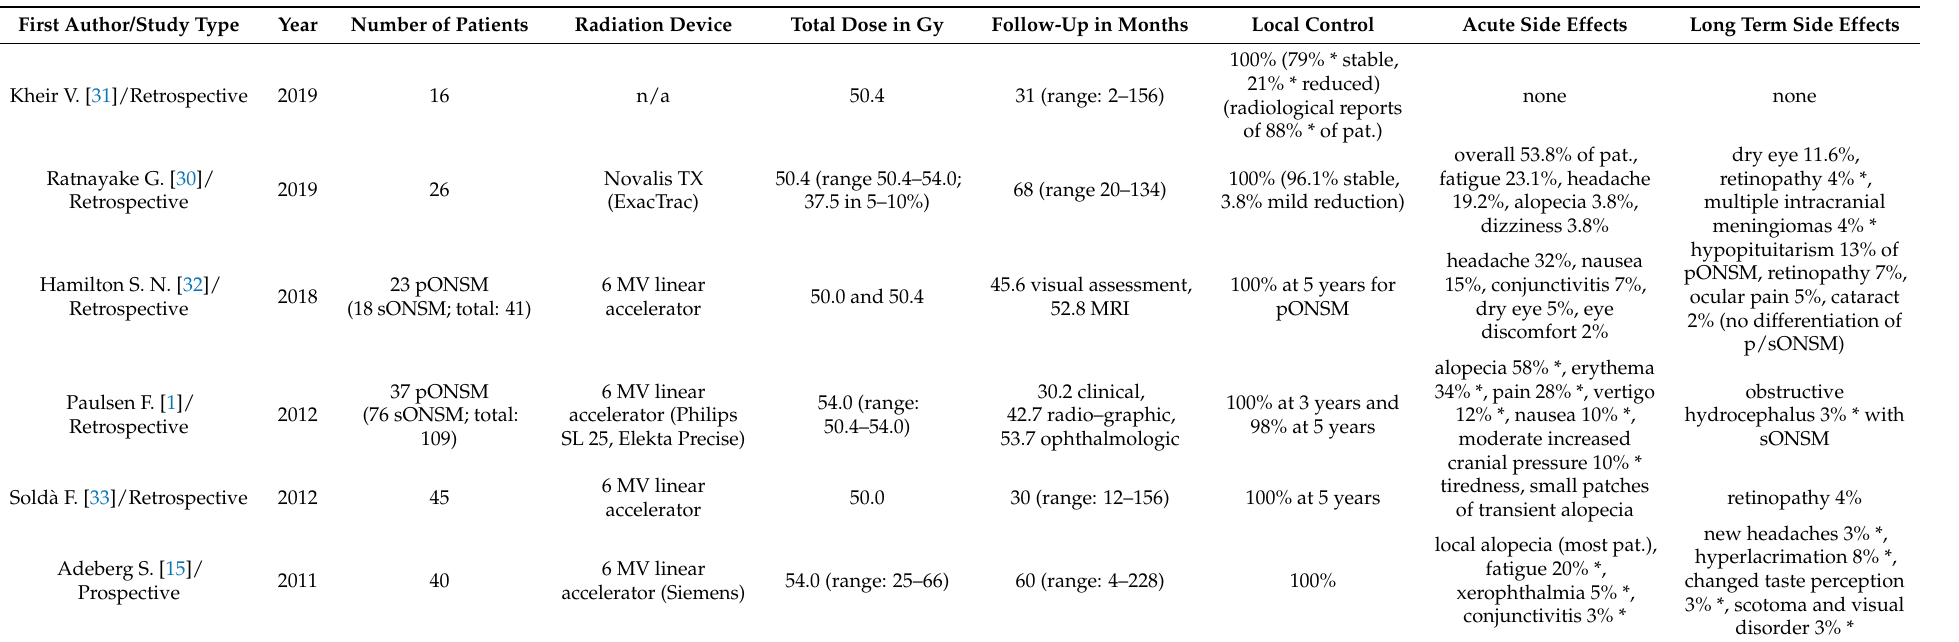
Table 5. Overview of recently (since 2011) published fractionated stereotactic radiotherapy studies for